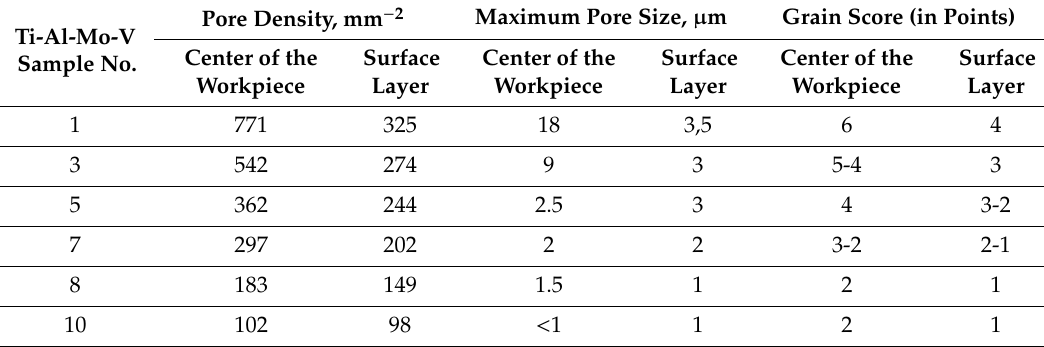
Table 4. Porosity and grain size (in points) depending on the degree of reduction.